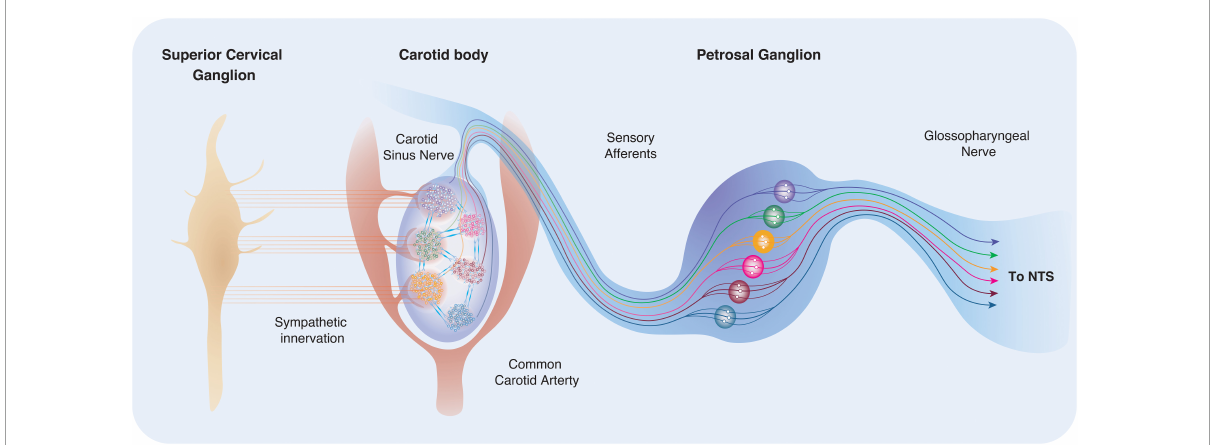
FIGURE3 Carotid body location, innervation and connectivity. The carotid bodies reside in the bifurcation of the common carotid artery bilaterally and are highly vascularised. Recent work suggests that arterioles within the carotid body are located predominantly to one side, making the “vascular side” more sensitive to sympathetic innervation. Type I cells receive postganglionic sympathetic fibers from the SCG via two nerves: the GGN and the carotid sinus nerve (CSN). Within the carotid body, regional clusters may be sensitive to distinct and specific stimuli (for example through differences in exposure, or differences in phenotype). Activation of different lobules or clusters may be connected to defined physiological outputs and reflex arcs. This theory has previously been described as the “Ribbon Cable” (e.g., a multi-wire planar cable) hypothesis (Zera et al., 2019).